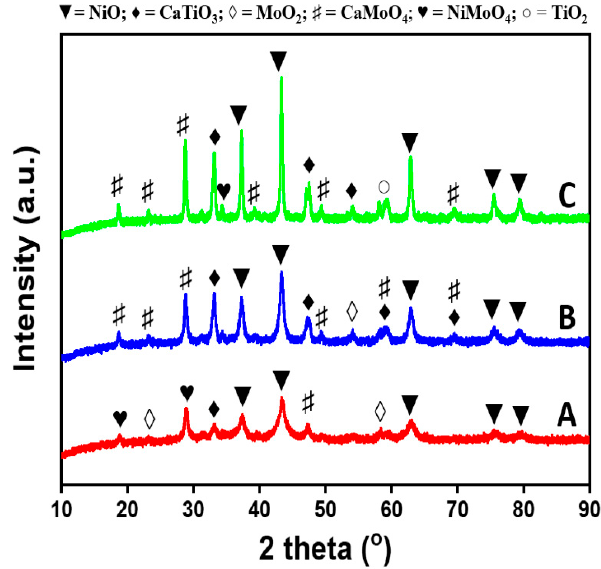
Figure 7. XRD pattern of the prepared NiMo/CaTiO 3 (NMC412) catalysts calcined at different